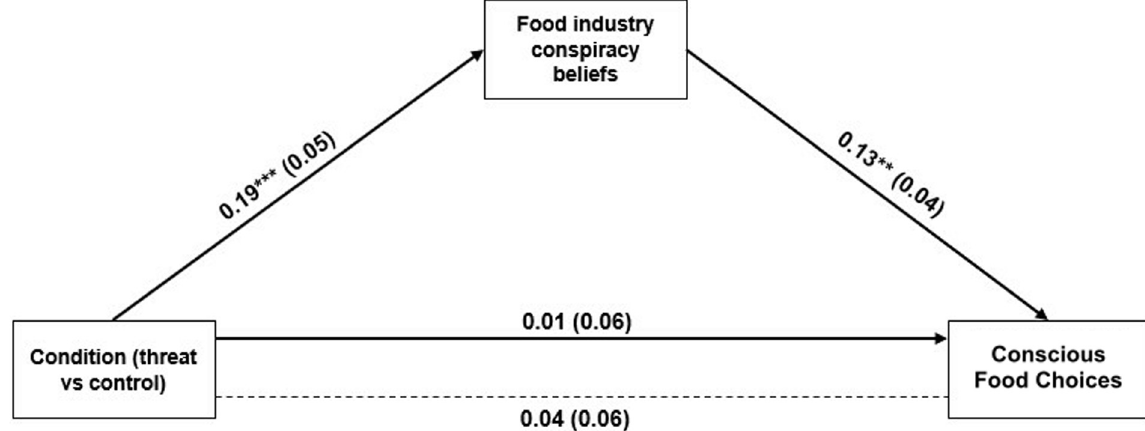
Fig 2. Indirect effect of condition (threat vs. control) on conscious food choices via food industry conspiracy beliefs (Study 2). Entries are unstandardized coefficients. Dotted line indicates total effect (not controlling for the third variable). � p < .05. �� p < .01. ��� p < .001.